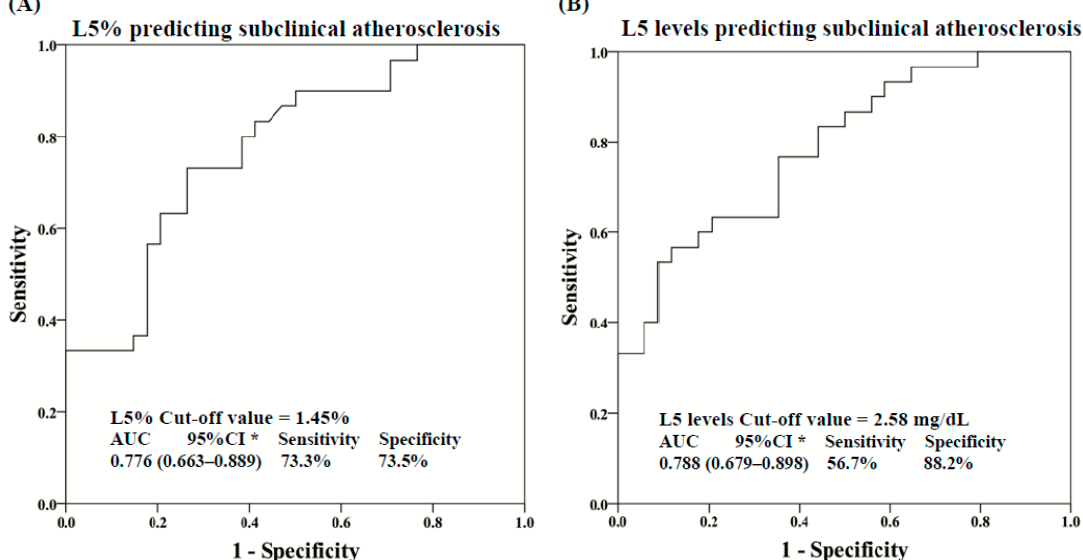
Figure 3. ROC curve analysis for plasma L5% and L5 levels in RA patients. ROC curve analysis of the cut-off values of plasma ( A ) L5% and ( B ) L5 levels for predicting the emergence of subclinical